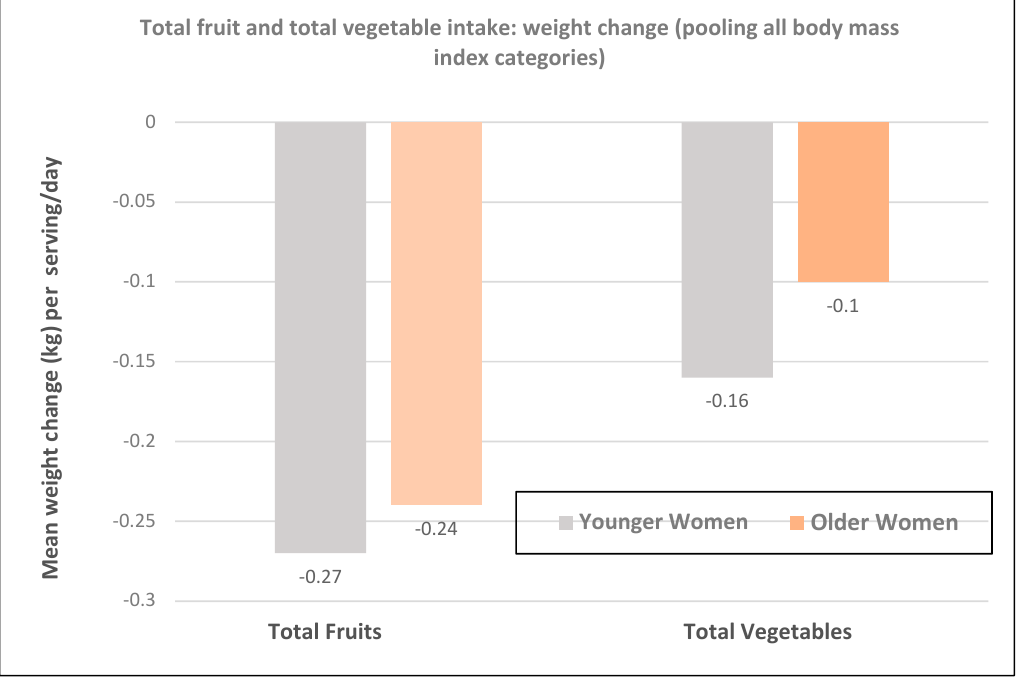
Figure 3. Multivariate association between increased total fruit and total vegetable intake per serving/day and weight change in younger (NHS II; mean baseline age 36-years) and older women (NHS; mean baseline age 49-years) per 4-year period [18].